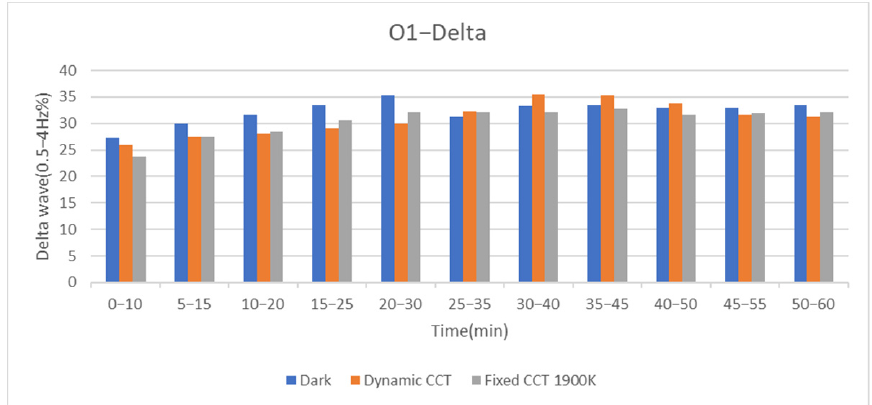
Figure 22. O1 δ wave analysis. There is no difference in the statistical results of brain wave O2_Delta, but the results of O2_Delta are similar to those of O1_Delta. After 25–35 min, the delta brain wave energy shows a strong trend under the sleeping environment with dynamic sleep aid light, as shown in Figure 23.